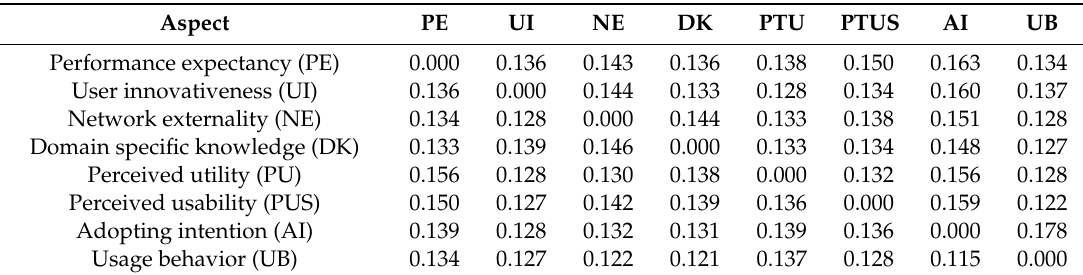
Table A4. The normalized direct-influence matrix N .